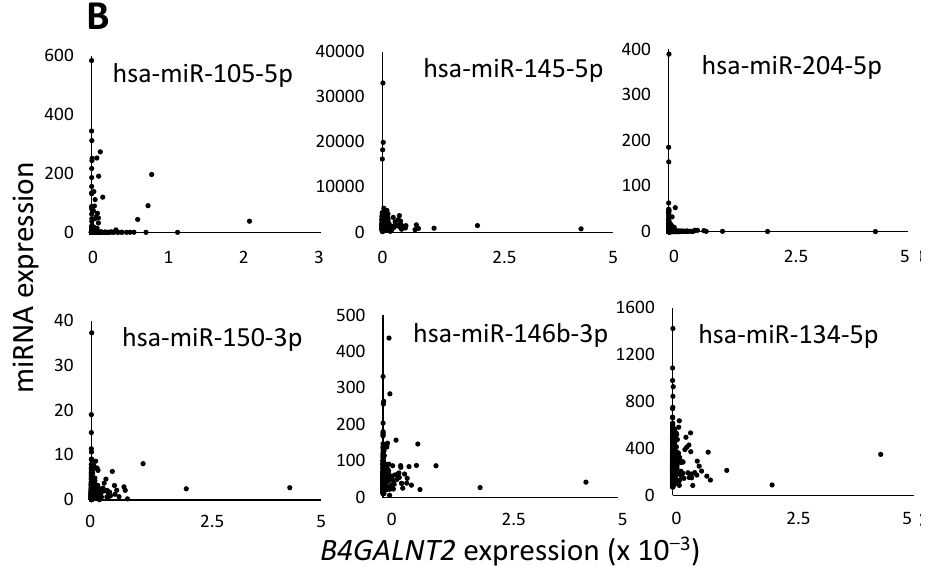
Figure 5. Correlation of B4GALNT2 and miRNA expression. ( A ) miRNA potentially targeting B4GALNT2 were obtained from the CSmiRTar database. Only miRNA supported by at least two of the four miRNA prediction target databases and with a “normalized miRNA score, NMR” >0.2 were considered. LBE and HBE represent the expression of the miRNA in the LBE ( B4GALNT2 expression = 0) or HBE ( B4GALNT2 expression closest to 367) cohorts. The only significantly modulated miRNA is indicated in bold. * Student’s t test for independent samples. ( B ) dot plot correlation analysis of the miRNA and B4GALNT2 expression